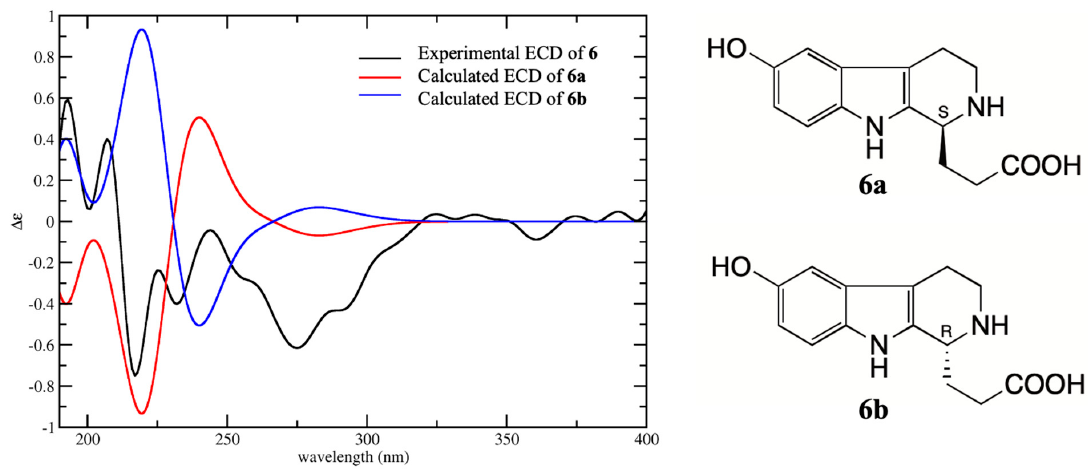
Figure 4. Experimental CD spectrum of 6 in H 2 O and the calculated ECD spectra of (1 S )-6 ( 6a ) and (1 R )-6 ( 6b ).